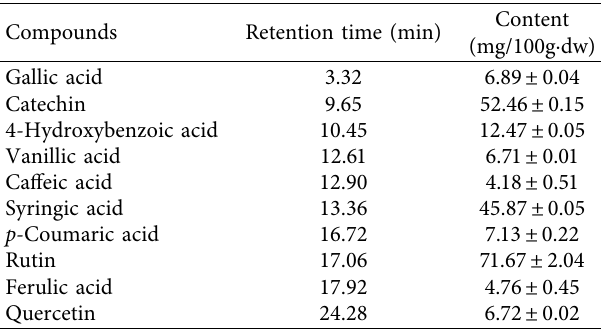
Table 6: HPLC quantification of phenolic compounds in avocado seed extract under optimal MAE